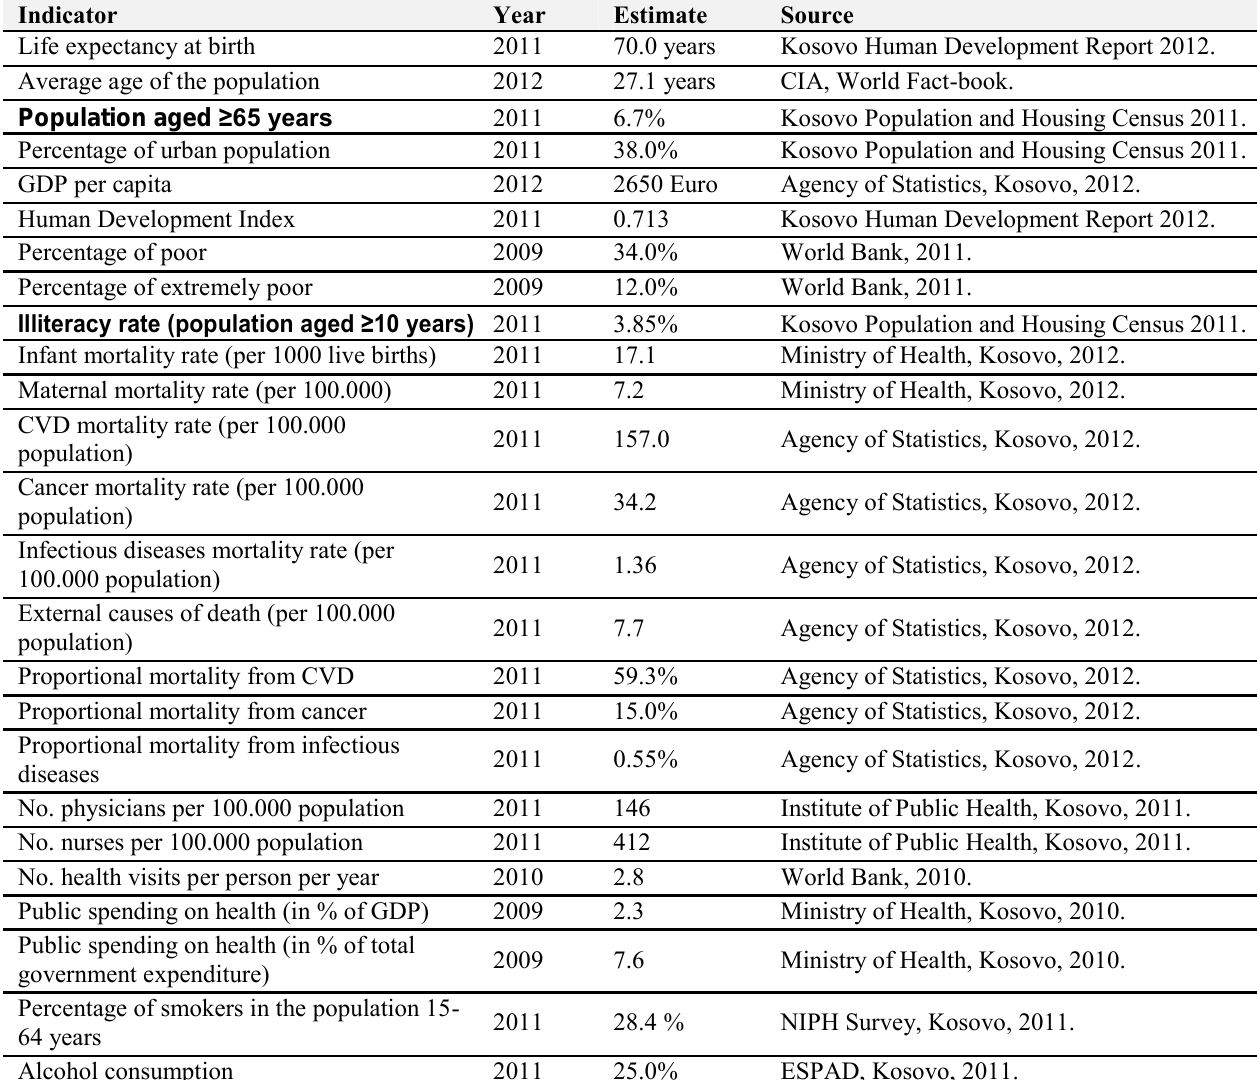
Table 1. Selected socioeconomic and health indicators in